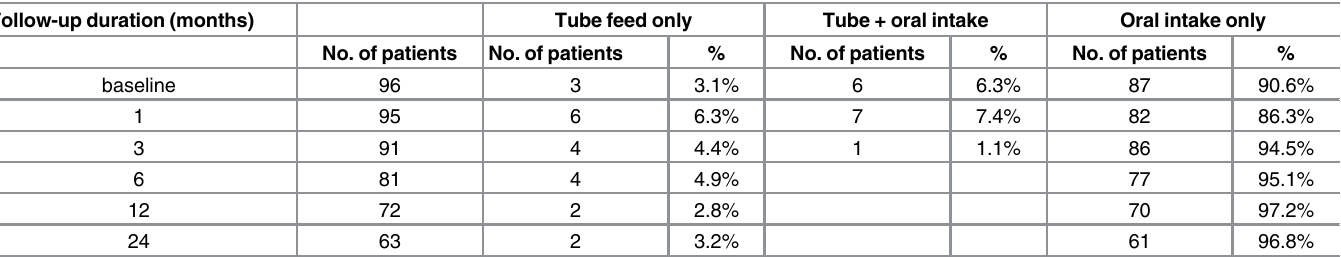
Table 3. Swallowing